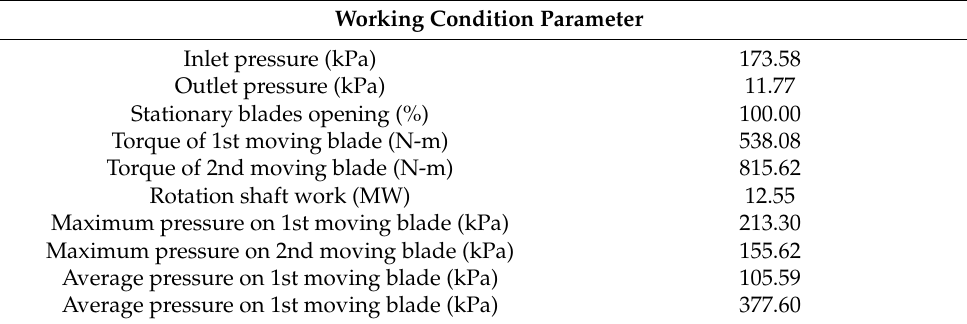
Table 4. CFD analysis result.